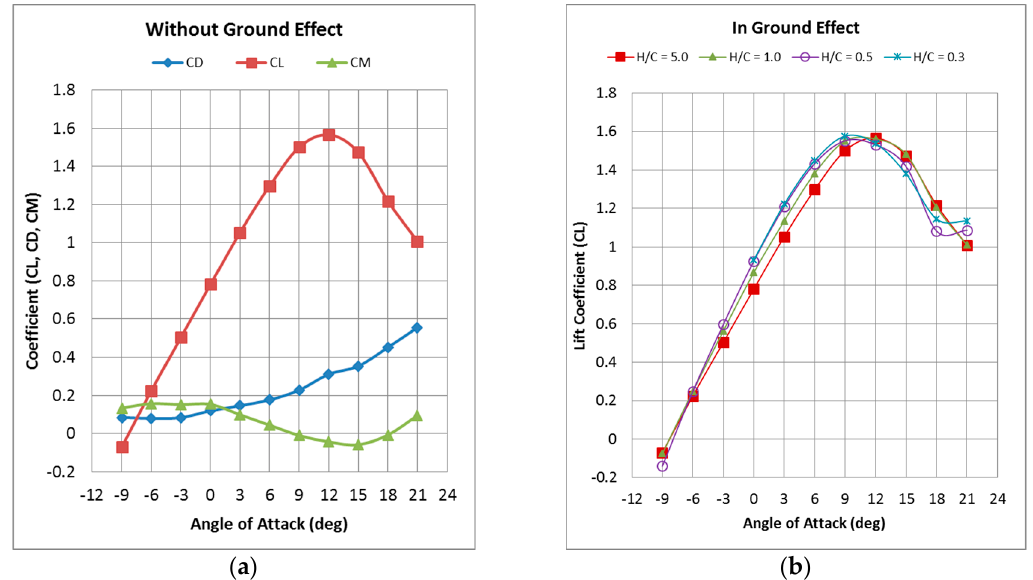
Figure 3. ( a ) Lift, drag, and moment coefficients at 25% C of the WIG craft without Ground Effect, ( b ) Lift coefficient of the WIG craft in ground effect.